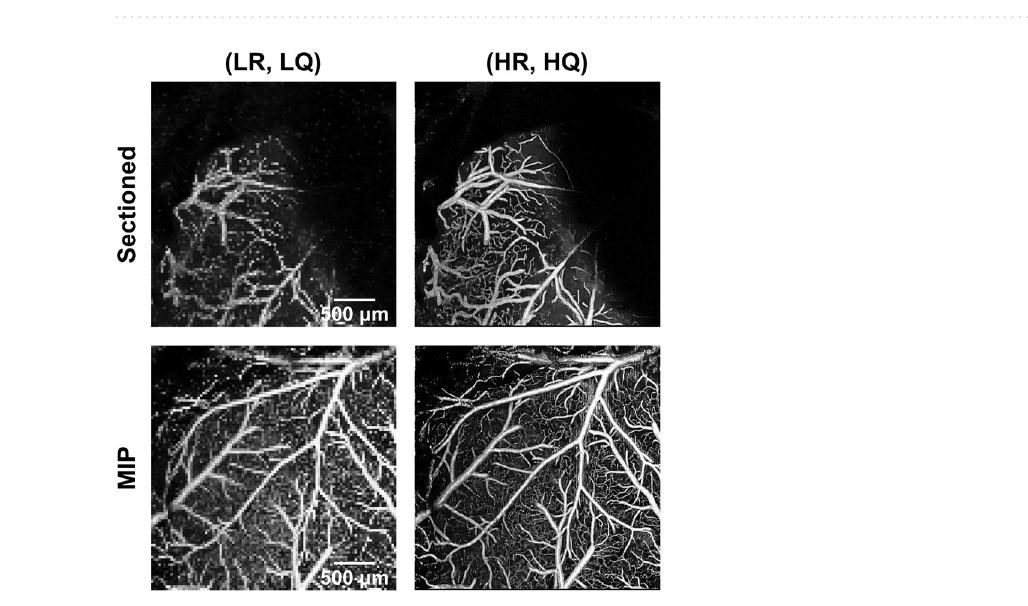
Figure 2. Depiction of how depth-wise sectioned enface angiograms differ from maximum intensity projection (MIP) enface angiograms. The left column illustrates the low-resolution, low-quality (LR, LQ) angiograms from two repeated downsampled B-scans (downsampling ratio of four). The right column illustrates the corresponding high-resolution, high-quality (HR, HQ) angiograms from eight repeated fully-sampled